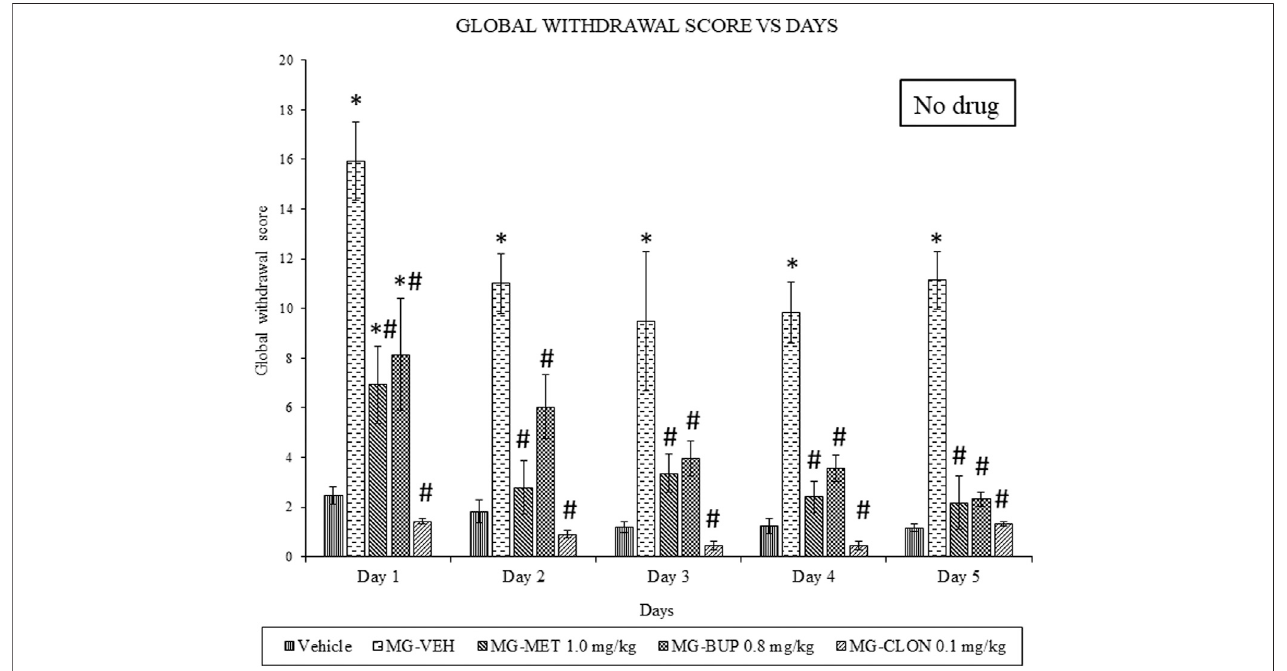
FIGURE 1 | Methadone (MET), Buprenorphine (BUP) and Clonidine (CLON) reduced behavioural signs of mitragynine withdrawal in rats. Data represent means ( ± SEM) of global withdrawal signs ( n (cid:1) 6/group; * p < 0.05, vs. Vehicle, # p < 0.05 vs. mitragynine-vehicle, MG-VEH).